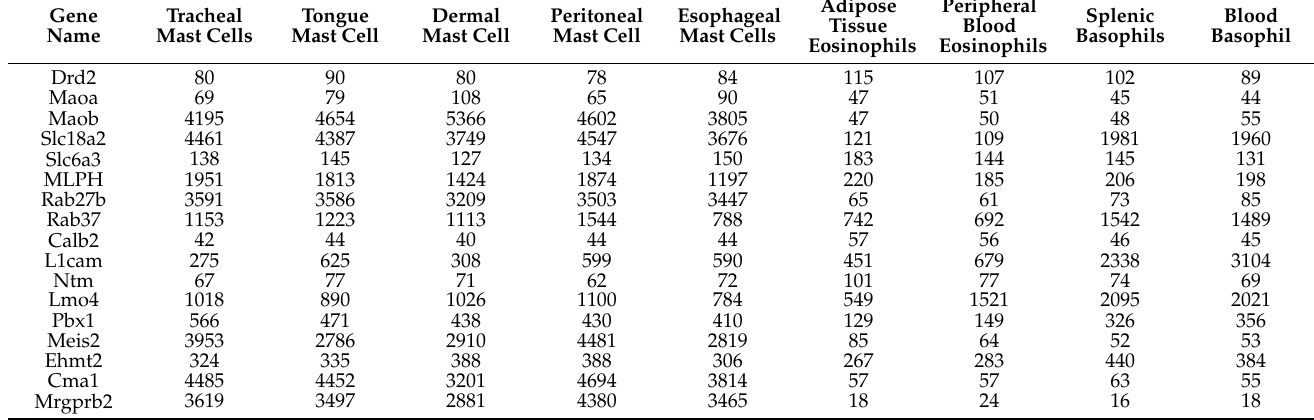
Table 5. Gene expression values were extracted from the ImmGen database [224]. In the associated study [80], constitutive MCs from five tissues were analyzed using microarray-based gene expression analysis. Gene expression in basophils and eosinophils from two compartments each were likewise quantified. Expression is presented as RMA-normalized signal intensity for probe of corresponding gene (not log-transformed). (RMA = Robust Multichip Average, an approach to normalize each array against all